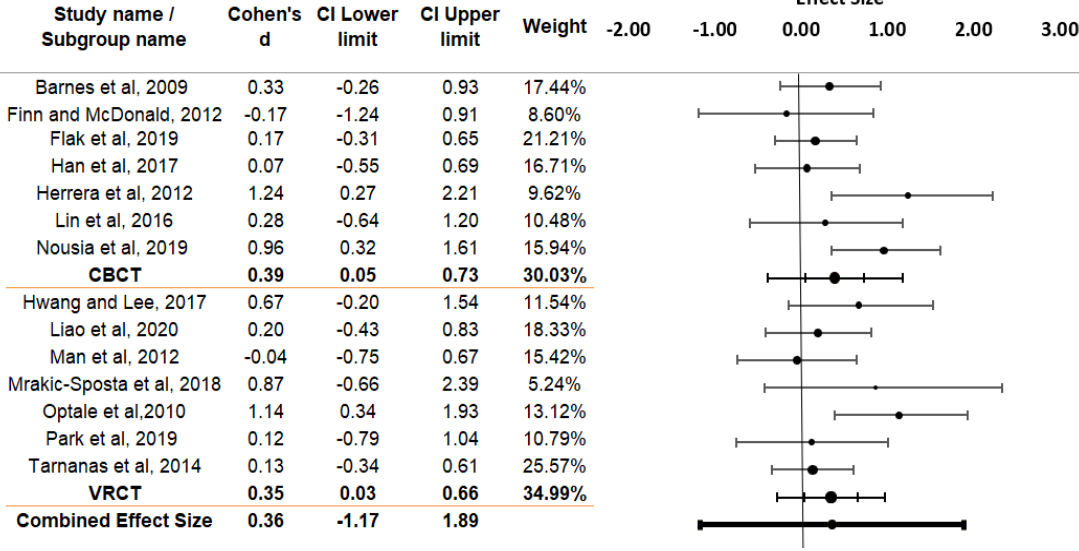
Figure 2. Forest plot of Mem.